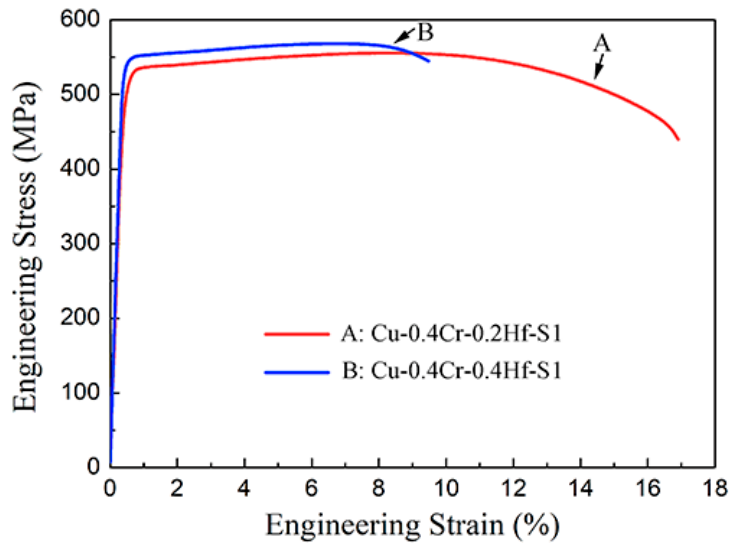
Figure 2. Typical tensile curves of Cu-0.4Cr-0.2Hf-S1 and Cu-0.4Cr-0.4Hf-S1.